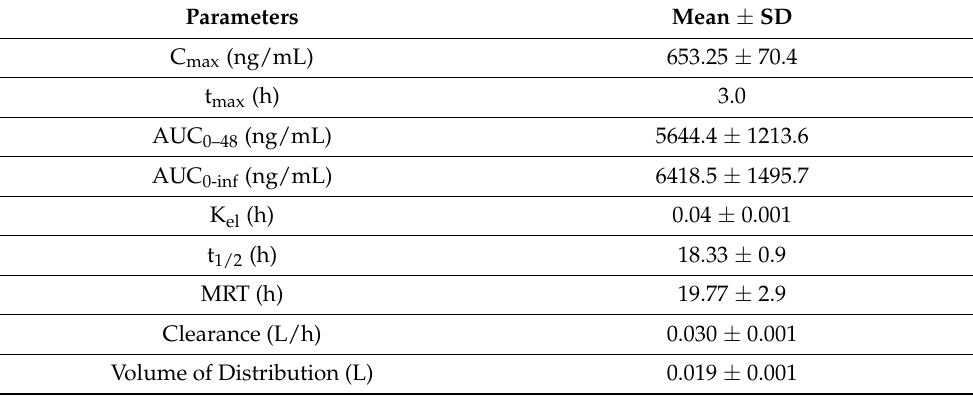
Figure 4. MRM Chromatograms of Tamatinib and Internal Standard in a Real Rat Plasma Sample Obtained at 1.0 h Following Oral Administration of 12.5 mg/kg of Fostamatinib. Table 5. Pharmacokinetic of Tamatinib Following Administration of 12.5 mg/kg to